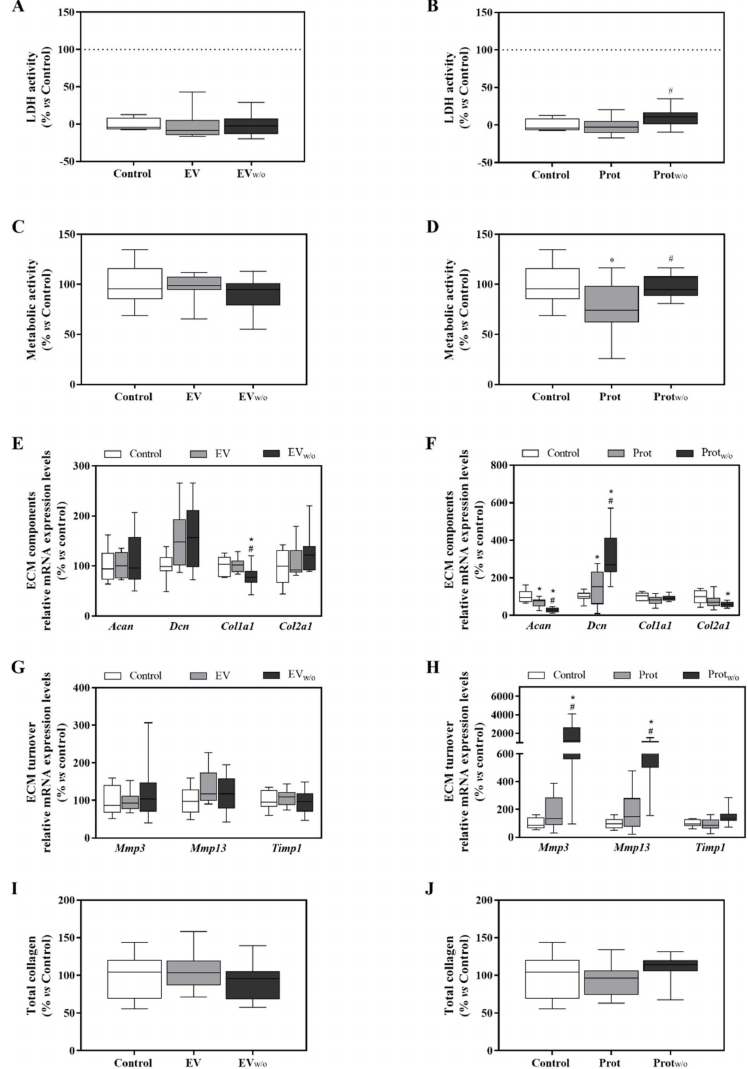
Figure 3. EV, EV w / o, Prot and Prot w / o isolates e ff ects on ATDC-5 chondrogenic cell line. ( A , B ) Lactate dehydrogenase activity was measured from cell culture media of ATDC-5 after 48 h of treatment with EV and EV w / o or Prot and Prot w / o . Negative control (0%) was the culture media from cells treated with the vehicle control. Positive control (100%) was the culture media from cells treated with 1% Triton X-100. ( C , D ) Metabolic activity measured after 48 h of treatment. Data were normalized to the vehicle control group that was set to 100%. ( E – H ) mRNA expression levels of ECM components genes ( Acan , Dcn , Col1a1 and Col2a1 ) or ECM turnover genes ( Mmp3 , Mmp13 and Timp1 ) of ATDC-5 after treatment with EV and EV w / o or Prot and Prot w / o for 48 h. Data represent fold changes of target genes, normalized to reference genes ( Rn18s and Gapdh ) and relative to the group control that was set as 100%. Values presented in box and whisker plots represent the median, minima and maxima of two independent experiments ( n = 11) Results in subfigures A , C – E , G and I were statistically compared by ANOVA and Bonferroni as post hoc for cytotoxicity, metabolic activity, Acan mRNA expression levels and total collagen deposition; and by Kruskal–Wallis for Dcn , Col2a1 , Mmp3 and Mmp13 mRNA expression levels: * p < 0.05 versus the control; # p < 0.05 versus Prot. Results in subfigures B , D , F , H and J were statistically compared by ANOVA and Bonferroni as post hoc for Acan , Col1a1 , Mmp3 , Mmp13 and Timp1 mRNA expression levels; and by Kruskal–Wallis for Col2a1 mRNA expression levels: * p < 0.05 versus Control; # p < 0.05 versus